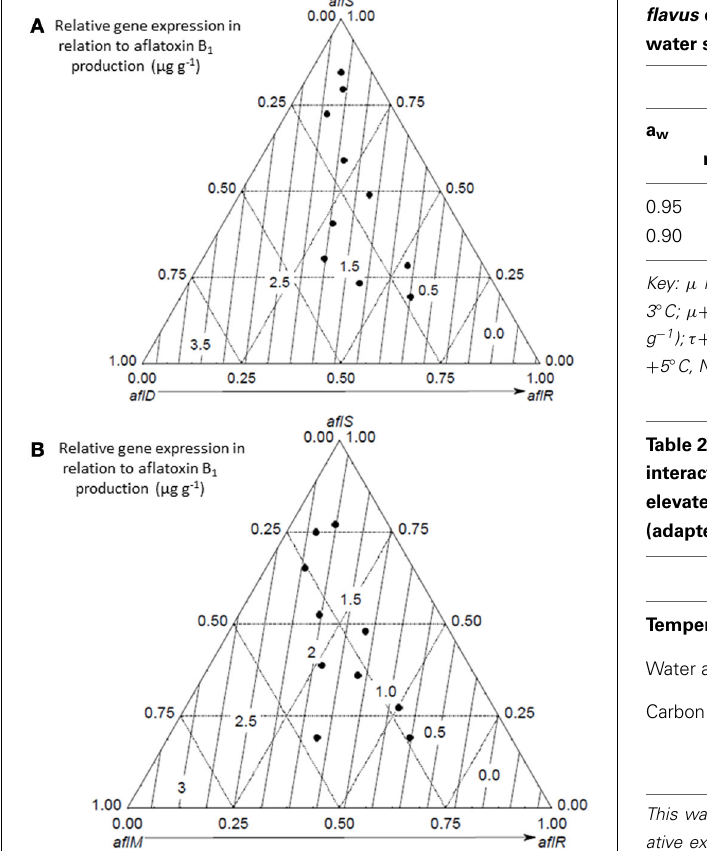
(0.95, 0.90 a w ) on growth and aflatoxin production ( Table 1 ).